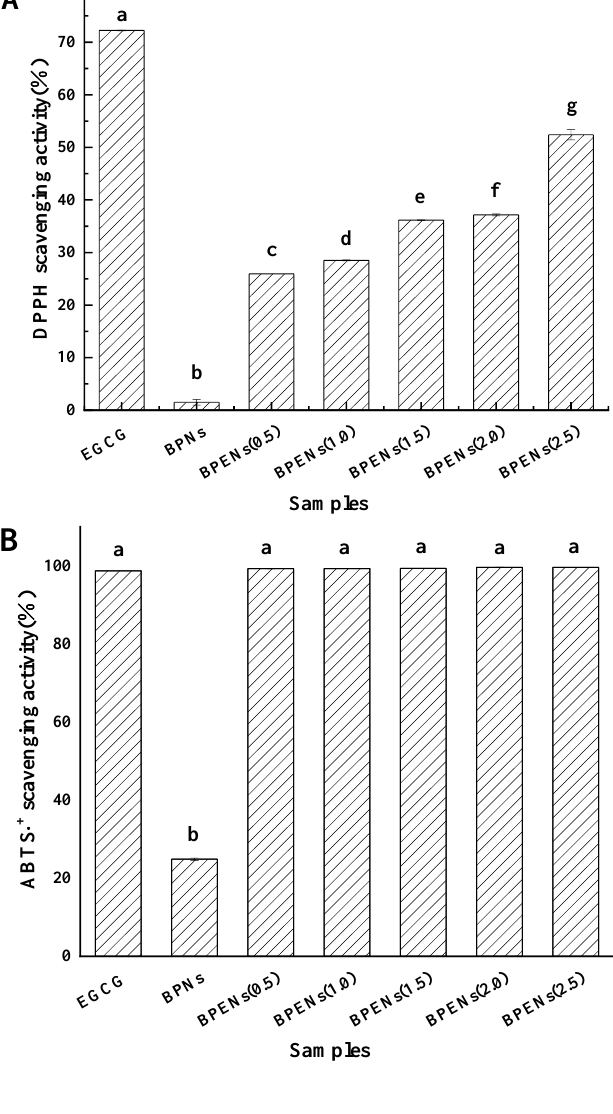
Figure 5B shows that the ABTS + free radical scavenging activity of the free EGCG was not very different from the activities of the free EGCG and BPENs that were loaded with different concentrations of EGCG. This shows that the nanoparticles can effectively improve the stability of EGCG and maintain its antioxidant activity. In line with the ideas of Laura et al. [39], we concluded that hydroxyl radicals are the most active oxygen- containing radicals, so the ability of BPENs to scavenge · OH is an important indicator of their antioxidant activity [40]. FRAP is measured by monitoring the change in Fe 3+ to Fe 2+ , which results from the electrons in the reducing substances [41]. As shown in Figure 5C, D, the FRAP scavenging activity and the hydroxyl radicals scavenging activity were also, in general, positively correlated with the sample concentration. Moreover, the free radical scavenging activity of free EGCG was not significantly different from that of the BPENs. When the concentration was increased, the free radical scavenging activity was significantly improved. This was mainly attributed to the higher surface area of the BPENs and the water solubility of EGCG after nanoencapsulation. The experimental results of the DPPH radicals scavenging activity and the ABTS + scavenging activity were consistent, and it was shown that nanoparticles can enhance or retain the antioxidant activity of catechins